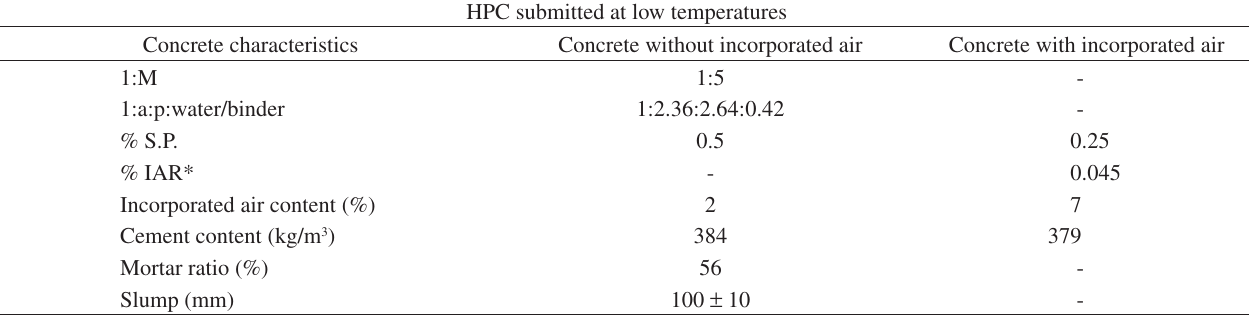
Table 3. Features for the HPC study in environments with low